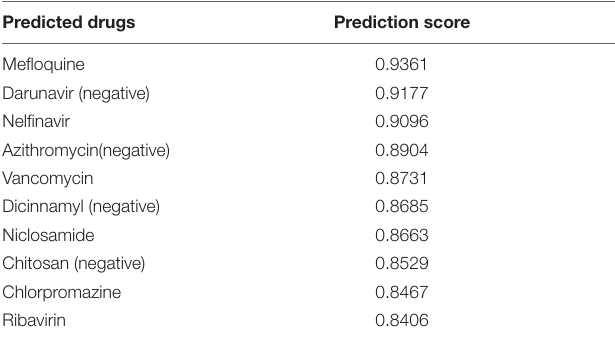
TABLE 6 | Predicted drugs that can treat SARS-CoV-2 (negative means that the drug is not associated with SARS in our dataset). Predicted drugs Prediction